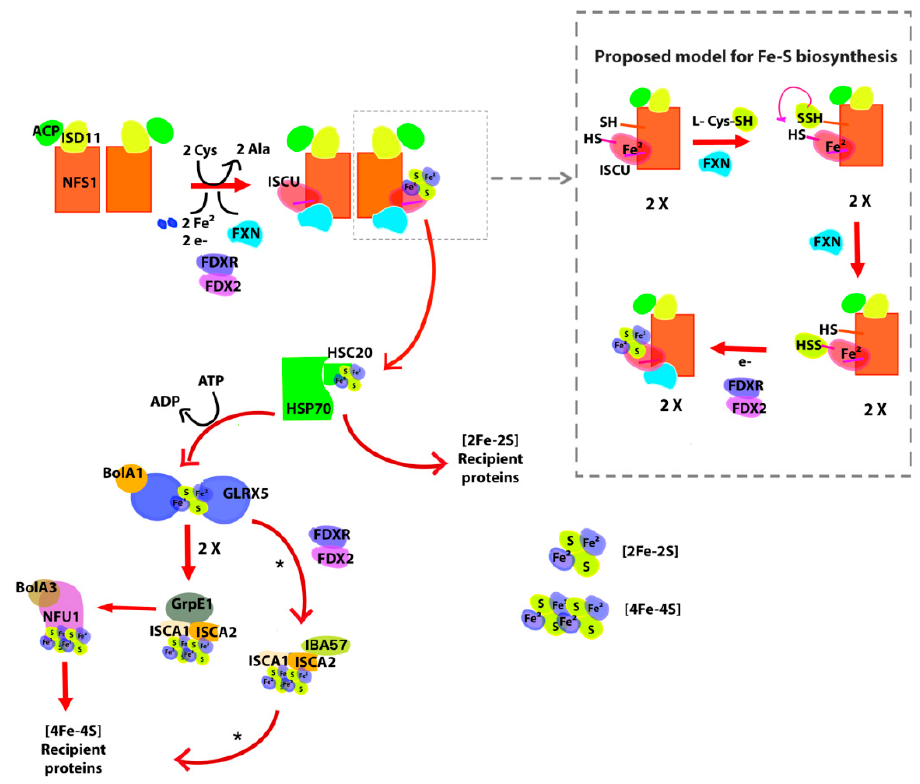
Figure 1. General scheme of iron sulfur cluster biogenesis in mammalian cells. Briefly, the ISU (in this case, (NFS1/ACP-ISD11/ISCU/FXN) 2 supercomplex (where ACP is the acyl carrier protein, ISCU